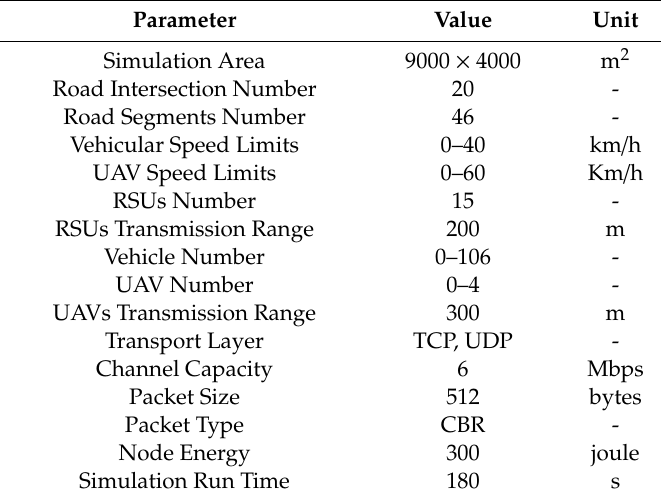
Table 2. Simulation